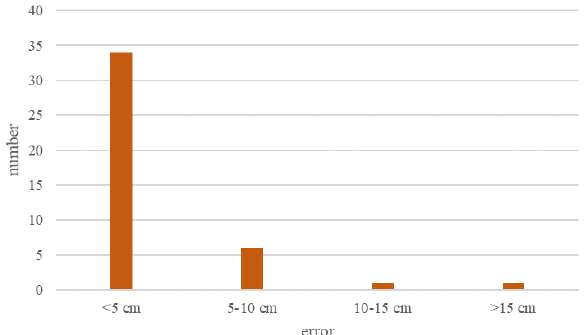
Figure 29. The statistics of two error analyses of the digitized line data.